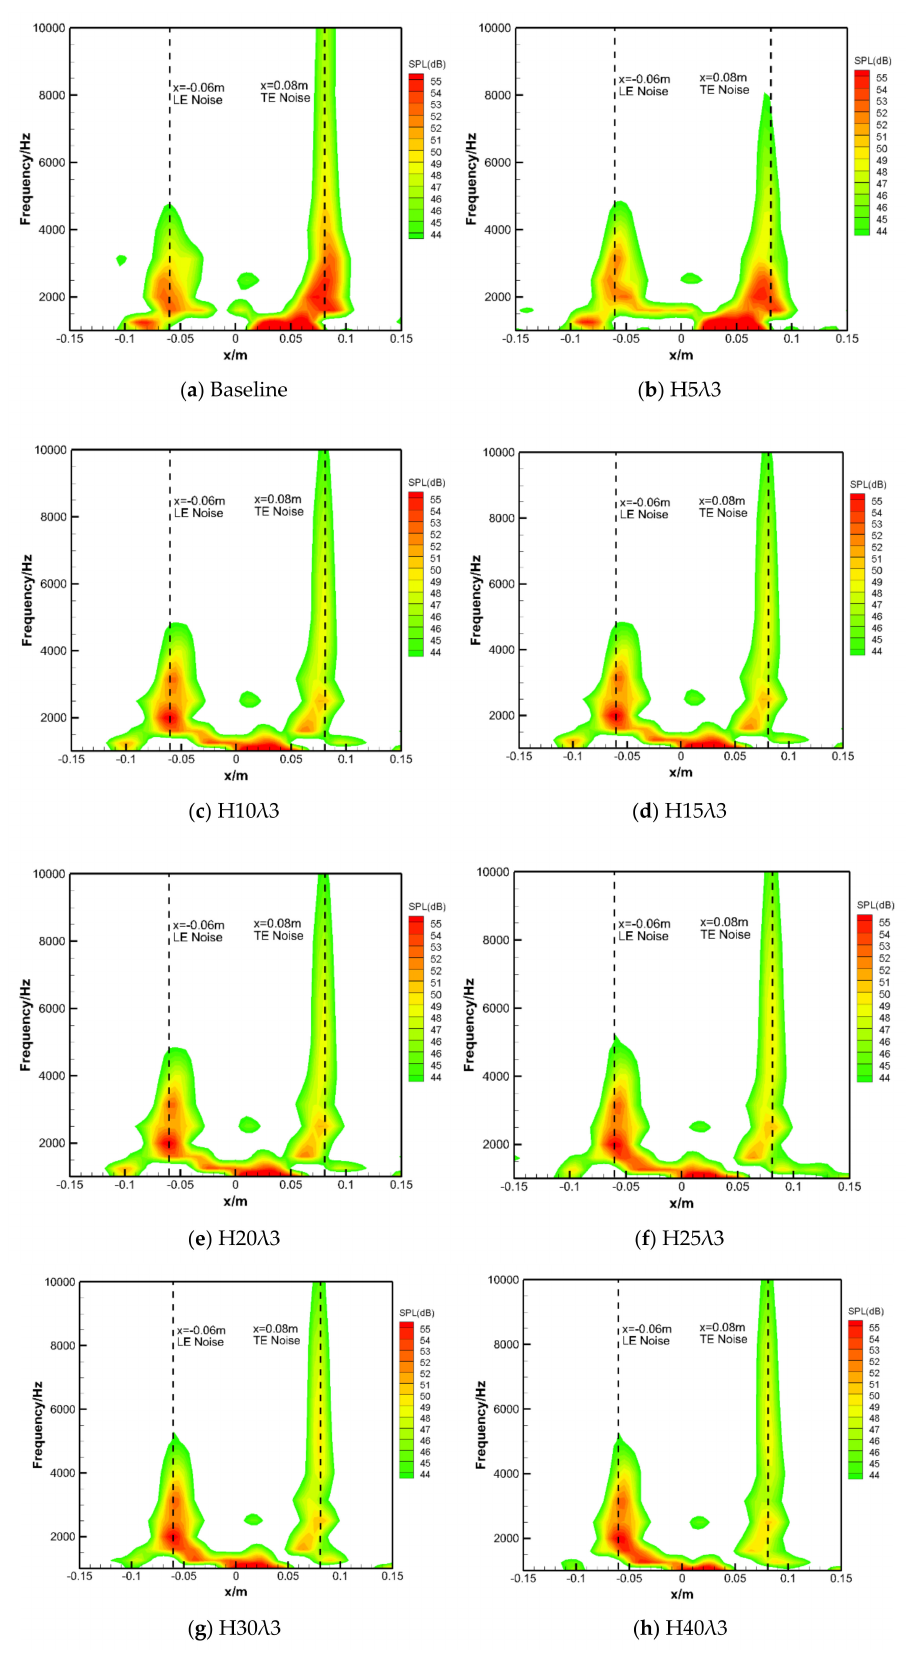
Figure 12. The sound source distribution of the blade with different sawtooth amplitudes (U = 40